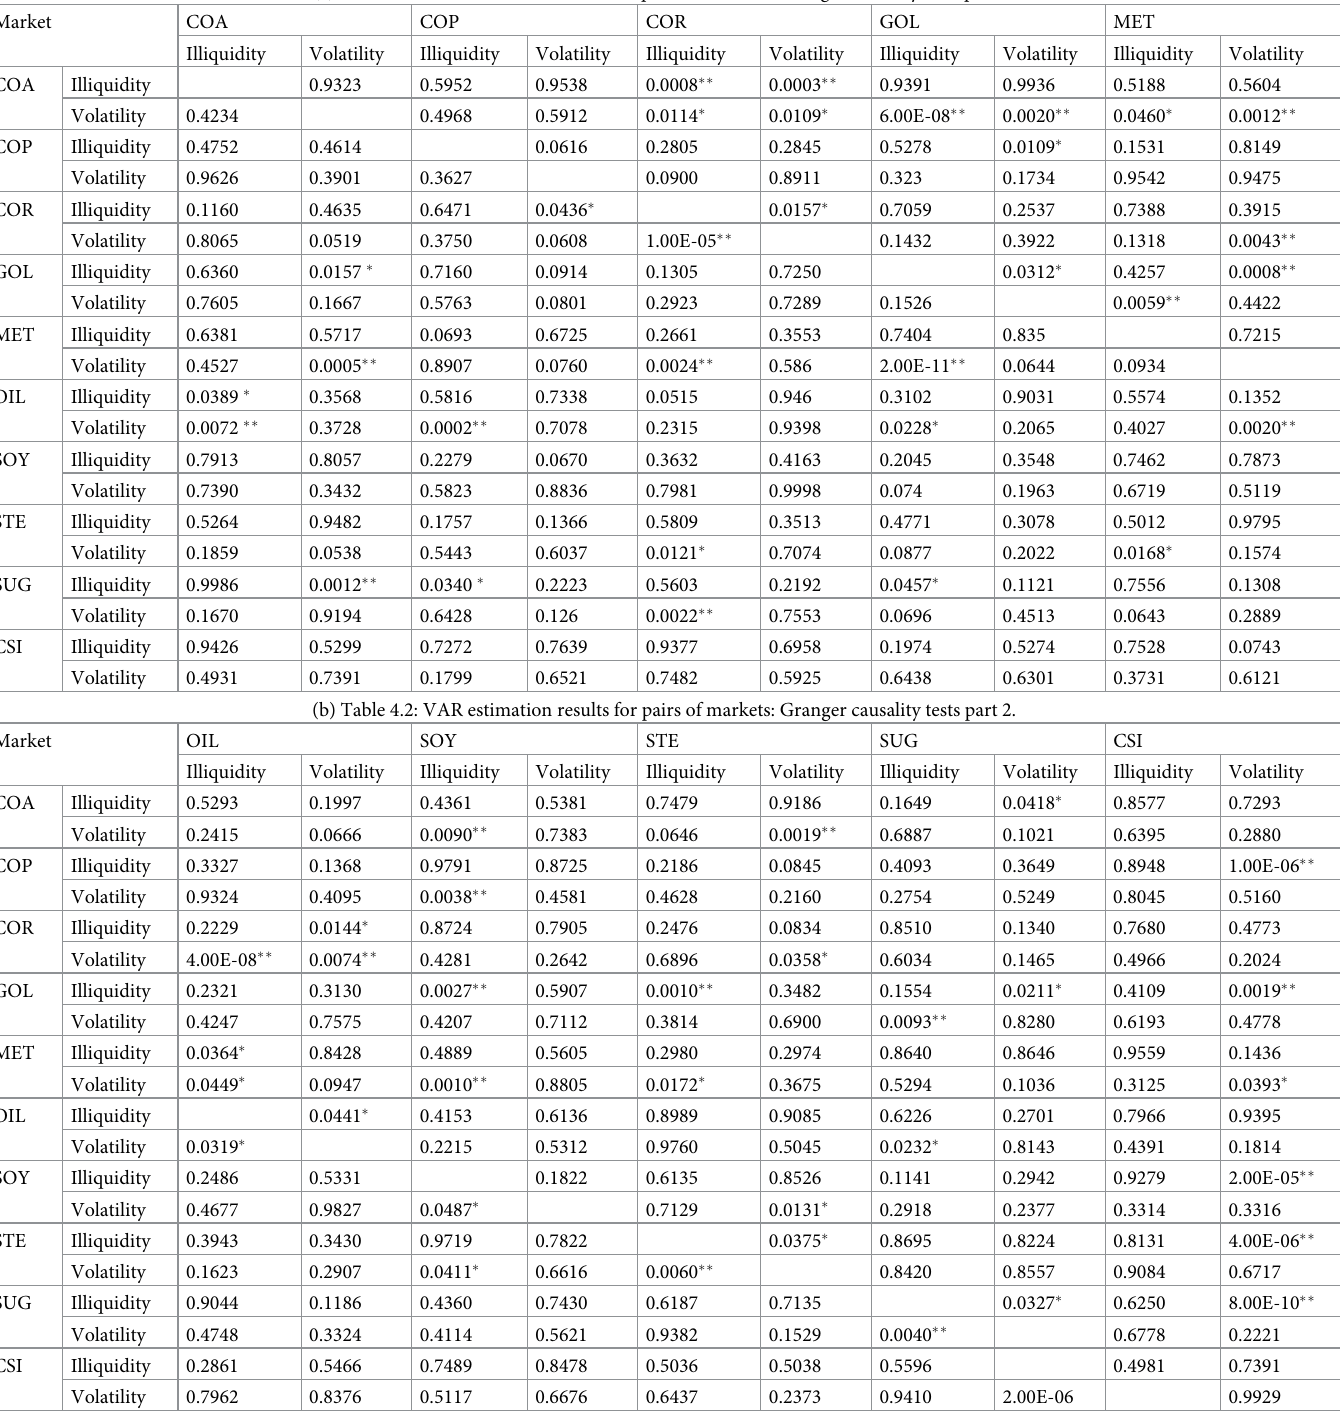
(a) Table 4.1: VAR estimation results for pairs of markets: Granger causality tests part